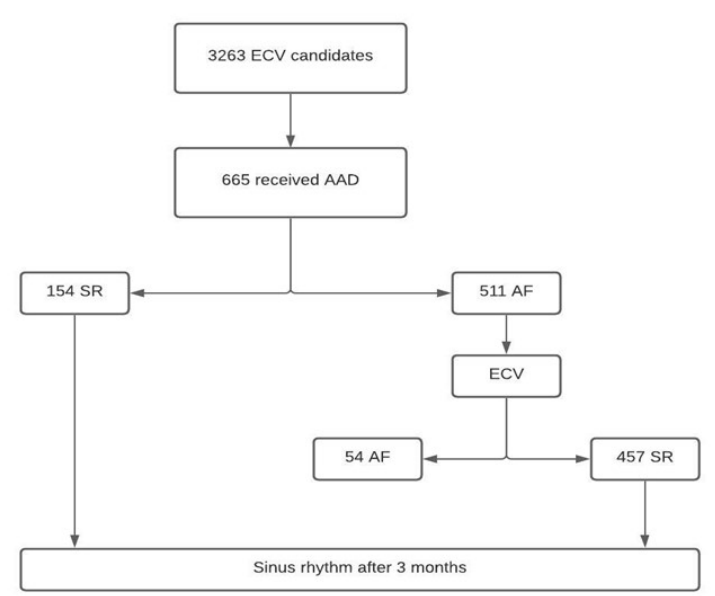
Figure 1. Selection process. AAD, antiarrhythmic drugs; AF, atrial fibrillation; ECV, electrical cardioversion; SR, sinus